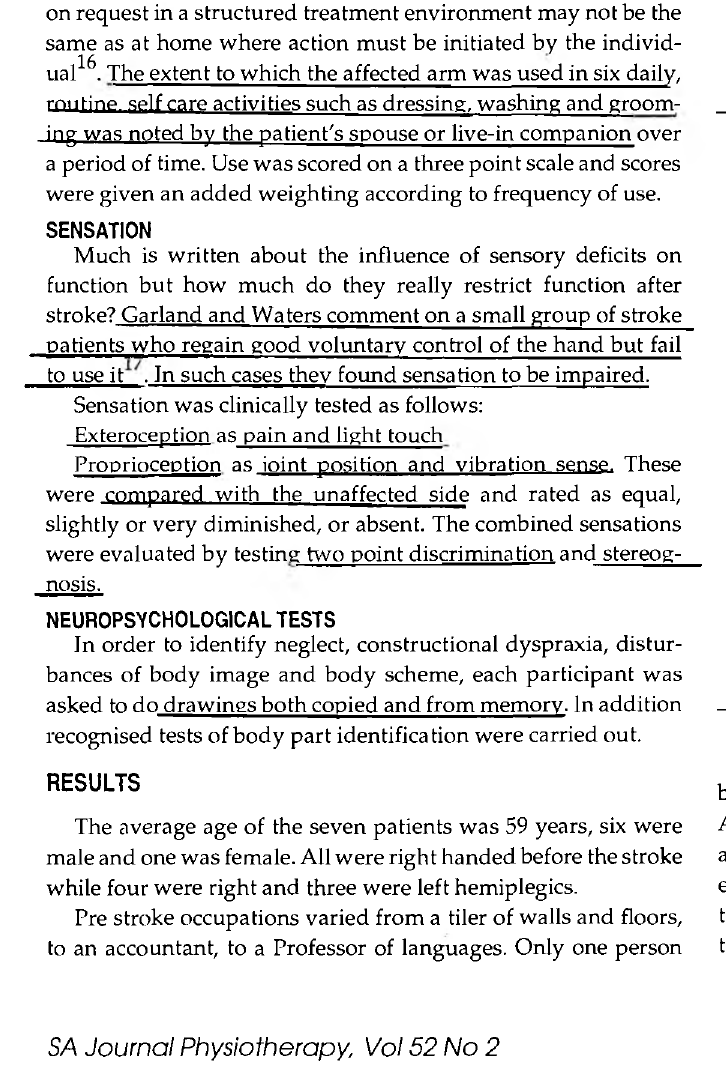
Figure 1: Correlation between motor function and